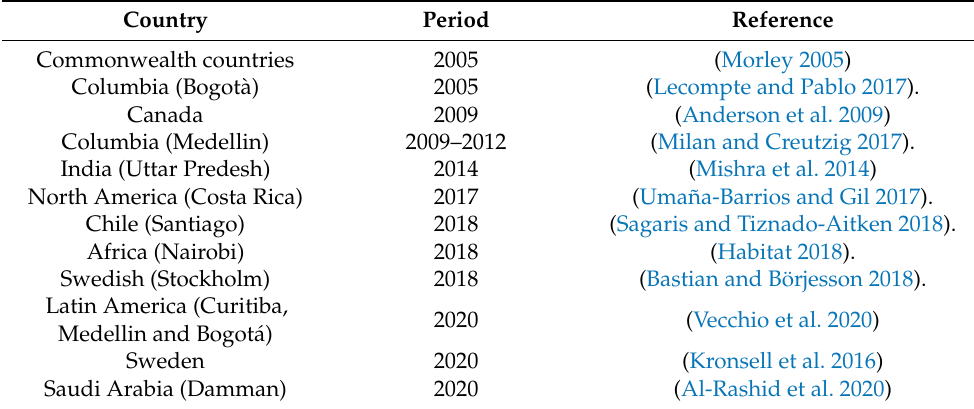
Table 1. Geographical spread of gender equality related to mobility concept. Country Period